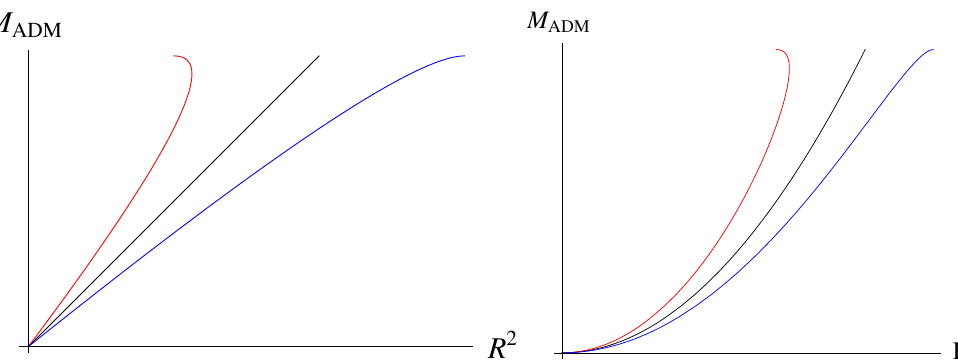
Figure 1 . Left: schematic ADM mass-volume (radius squared) curves for the BPS baby Skyrme model for (cid:10) < 2 (red), (cid:10) = 2 (black) and (cid:10) > 2 (blue). Right: corresponding M - R